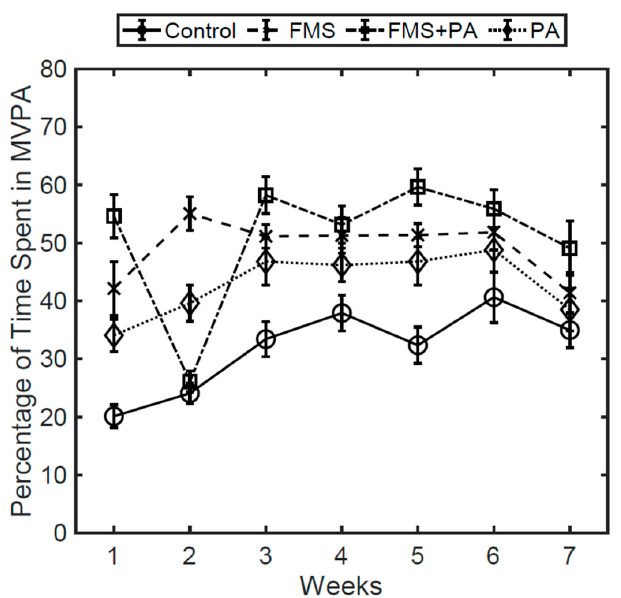
Int. J. Environ. Res. Public Health 2020 , 17 , 650 Figure 1. Percentage of time spent in MVPA by group across the intervention . Figure 1. Percentage of time spent in MVPA by group across the intervention.